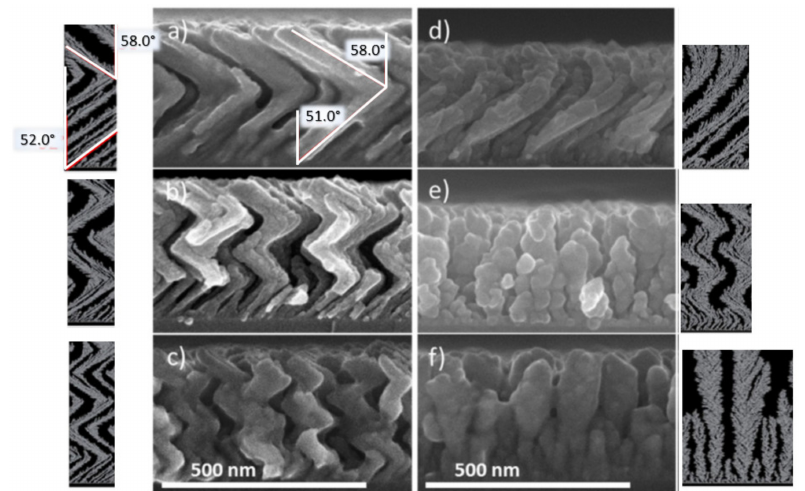
Figure 10. Ti thin films (150 W, 0.13 Pa, 85 ◦ ) deposited at various rotations of the substrate to generate: ( a – c ) Zigzag structures; ( d ) helicoidal structures at 0.1 ◦ / s; vertical pillars at ( e ) 1.0 ◦ / s and ( f ) 10.0 ◦ / s with the corresponding simulations. The red angle accounts for the average columnar tilt angle ( β ) (adapted from [50] with permission from Elsevier,